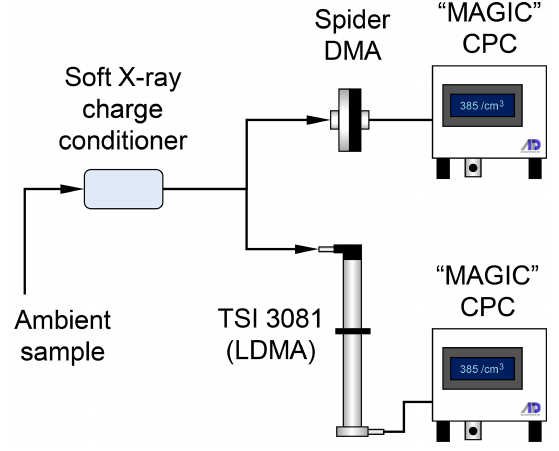
Figure 1. Schematic of the experimental setup used to evalu- ate the Spider DMA. The prototype instrument was operated at 0.9Lmin − 1 sheath and 0.3Lmin − 1 aerosol flow rates, with a scan- ning voltage program consisting of a 30s upscan followed by a 30s downscan. A TSI 3081 long-column DMA, operated at 3.0Lmin − 1 sheath and 0.3Lmin − 1 aerosol flows, with 240s upscans, was used for comparison. Both sizing systems used an ADI “MAGIC” CPC as the particle